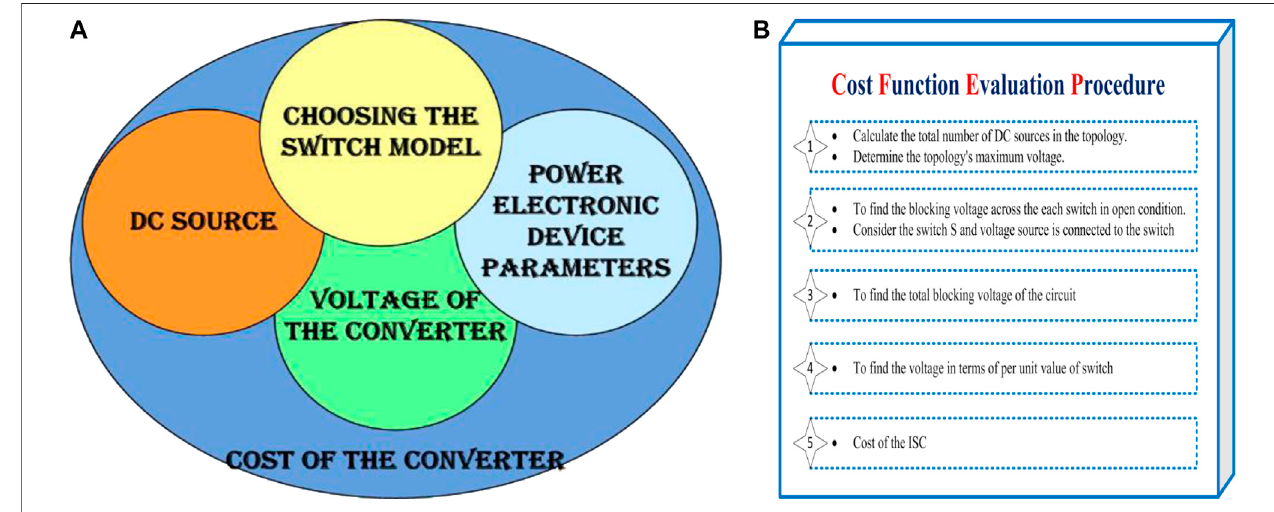
FIGURE 21 | (A) Factors considered for Cost of the converter (B) Process for estimating the ISC ’ s implementation costs.